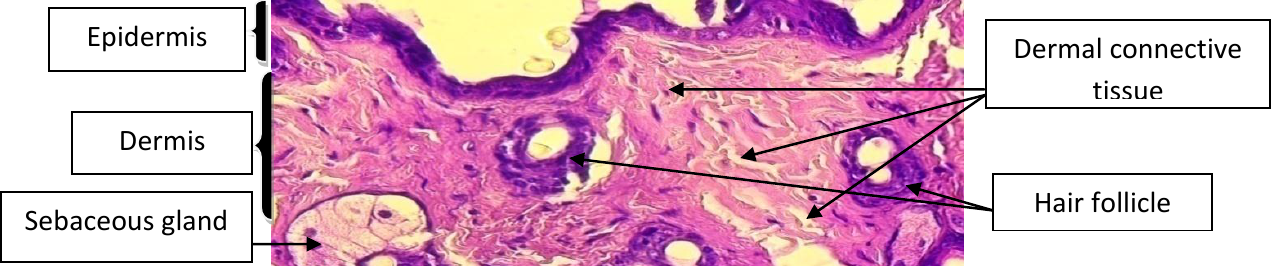
Figure (2): Section of mouse infected by phosphate buffer saline (H×E) in 40×- Power